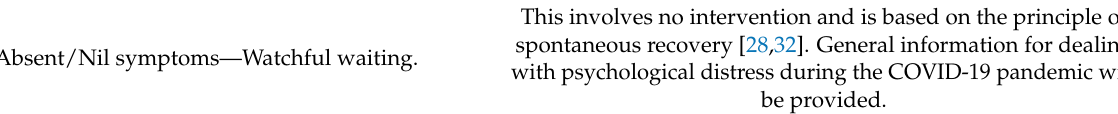
Table 1. Content of the MoodUP stepped care treatment